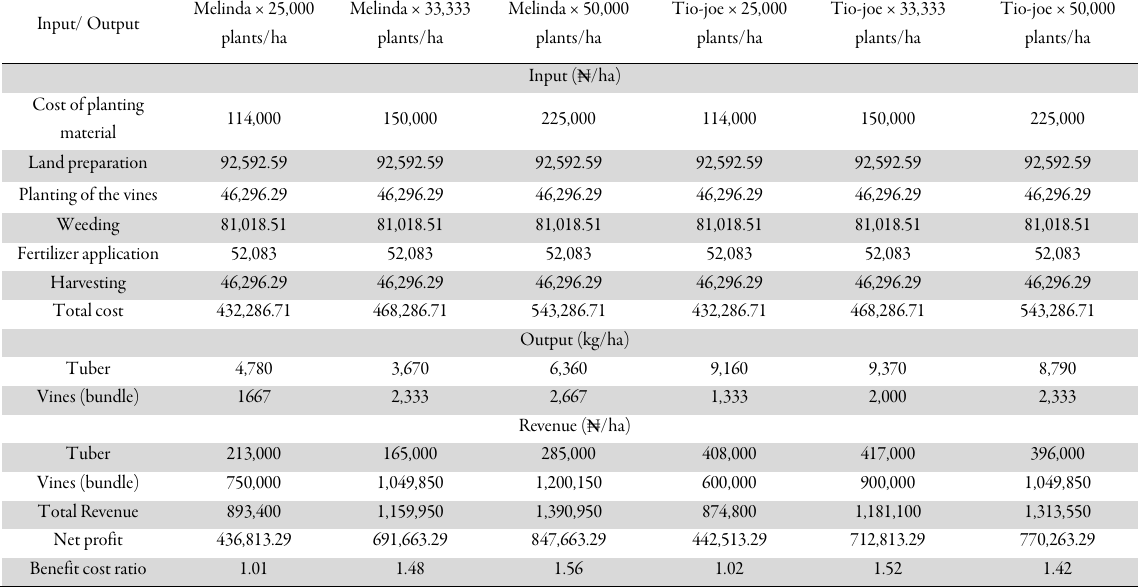
Table 3. Benefit cost ratio analysis of the orange-fleshed sweet potato at 2016 cropping season